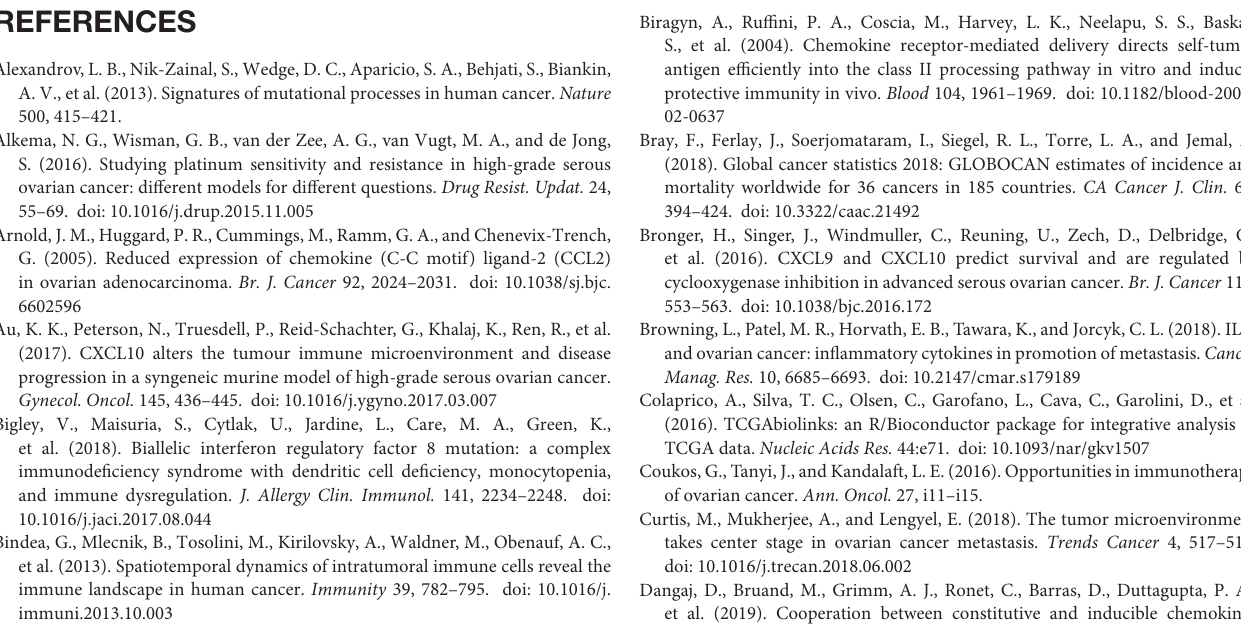
Supplementary Figure 3 | TME signature characteristics with CXCL10-related risk classification and prognostic value. (A) Distribution of TME signatures in two different risk classifications of three independent test cohorts. (B) Kaplan–Meier curves of prognosis of TME scores in three independent test cohorts. Supplementary Figure 4 | TME scores related clinical parameters and immune cell infiltration in ovarian cancer. (A) Merged data of all four cohorts. And it showed that the distribution of TME scores were stratified by both CXCL10 risk classification (high/low) and TME infiltration cluster (high/low). The